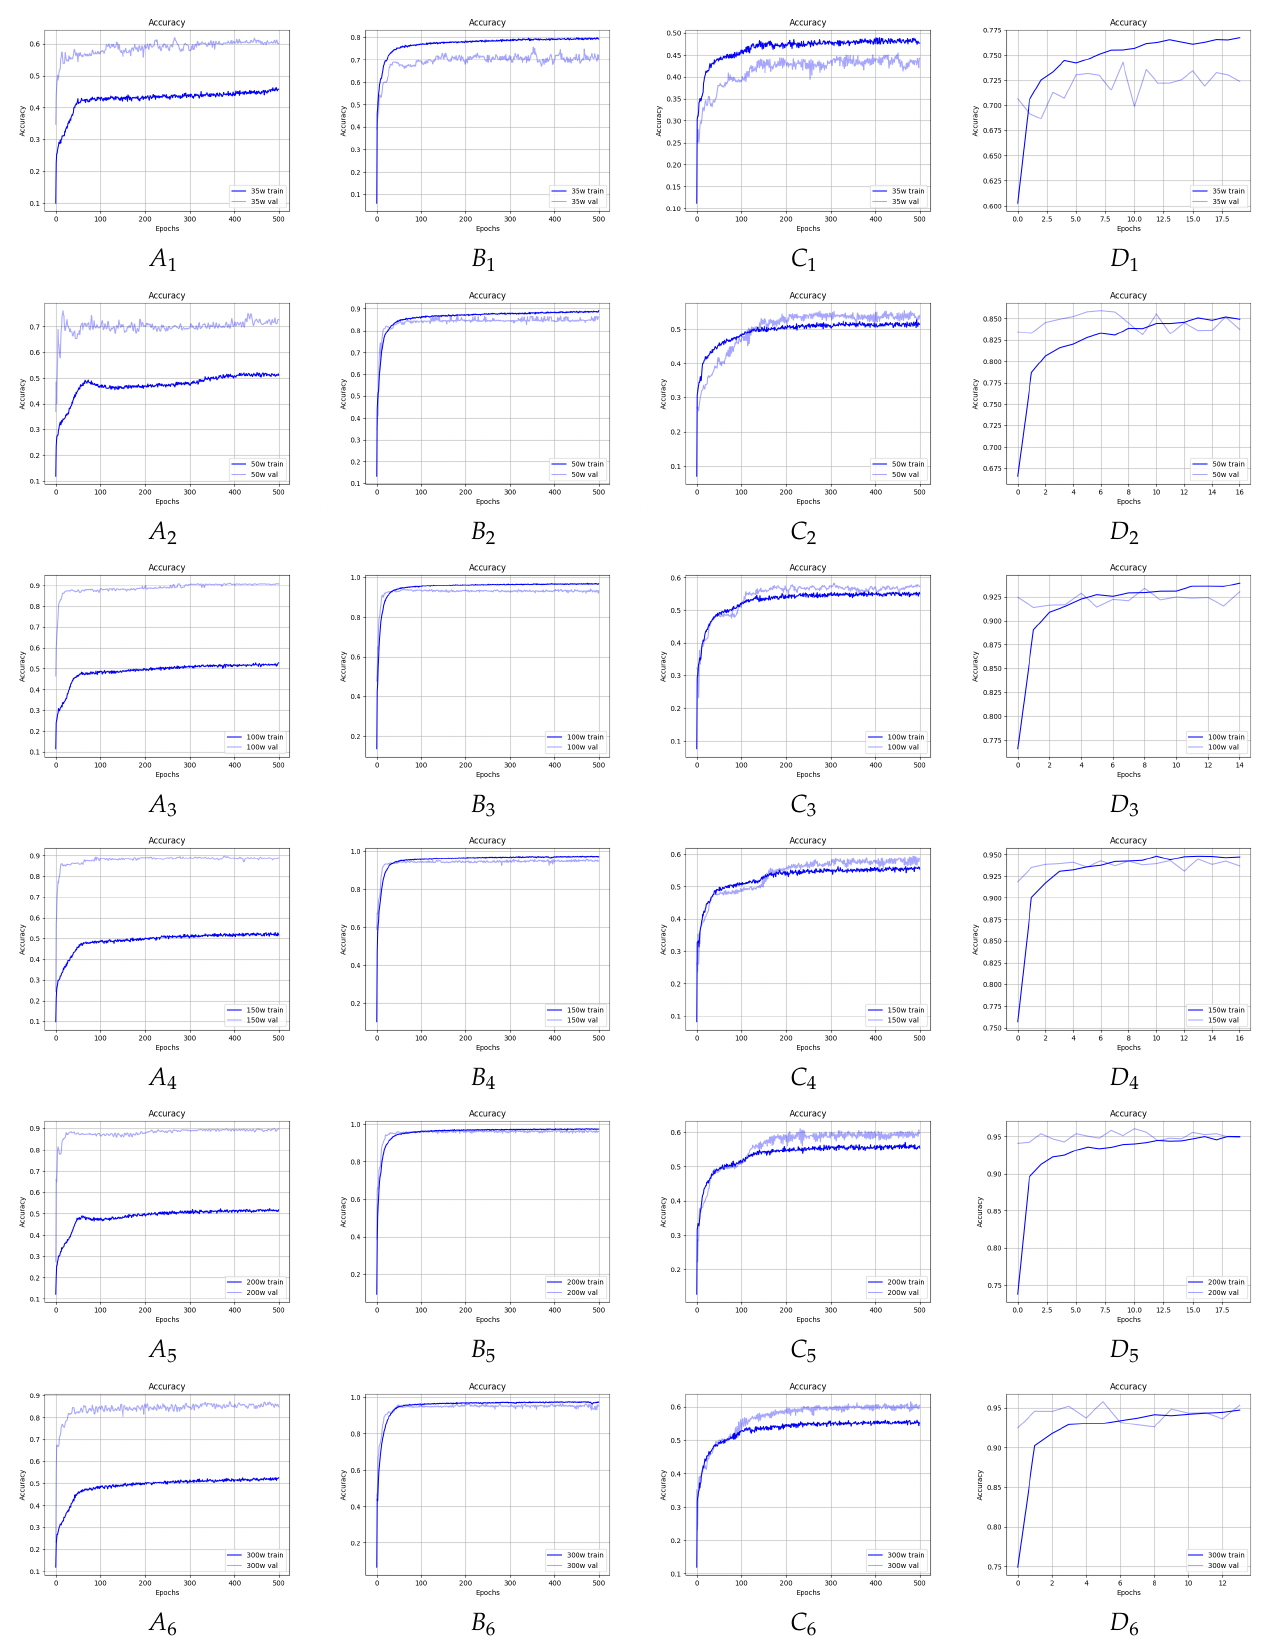
Figure 8. Accuracy waveforms for the ( A ) ARMA, ( B ) Chebyshev, ( C ) GAT, and ( D ) GraphSage models, which considered: 1. 35, 2. 50, 3. 100, 4. 150, 5. 200, and 6. 300